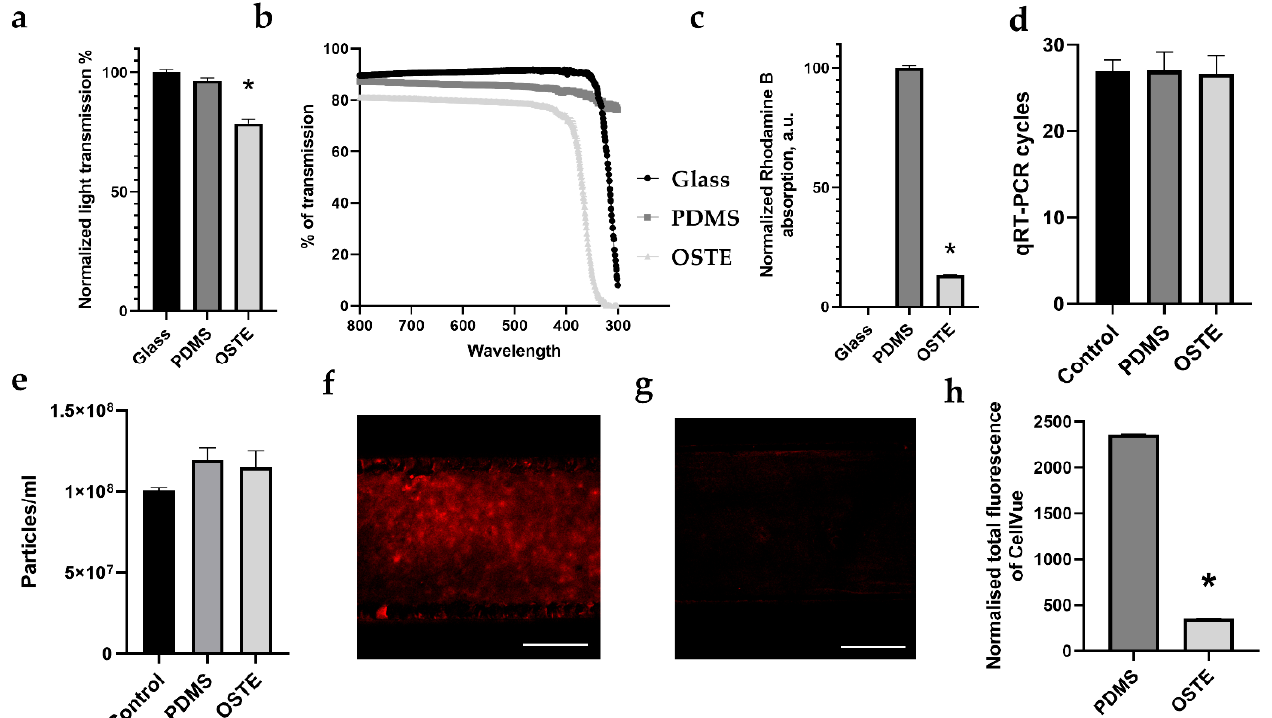
Figure 2. Comparison of PDMS and OSTE characteristics necessary for LOAC. ( a ) Comparison of total light transmission. ( b ) Comparison of light transmission across the 300–800 nm range. ( c ) Comparison of rhodamine absorption. ( d ) Comparison of PDMS and OSTE inhibition on quantitative reverse transcription (qRT)-PCR. Control represents lysate without polymer. ( e ) Comparison of extracellular vesicle absorption. Control represents input extracellular vesicle (EV) amount. ( f ) Image of CellVue absorption in PDMS single-channel device. ( g ) Image of CellVue absorption in OSTE single-channel device. ( h ) Quantitative comparison of CellVue absorption between PDMS and OSTE single channel devices. White scale bars represent 300 µ m. Bars represent mean value, and whiskers represent standard error in ( a , b , c , h ) and standard deviation in ( d , e ). * represents p value below 0.05. A.u. stands for arbitrary numbers. Data analysis and preparation of graphs were performed with GraphPad Prism